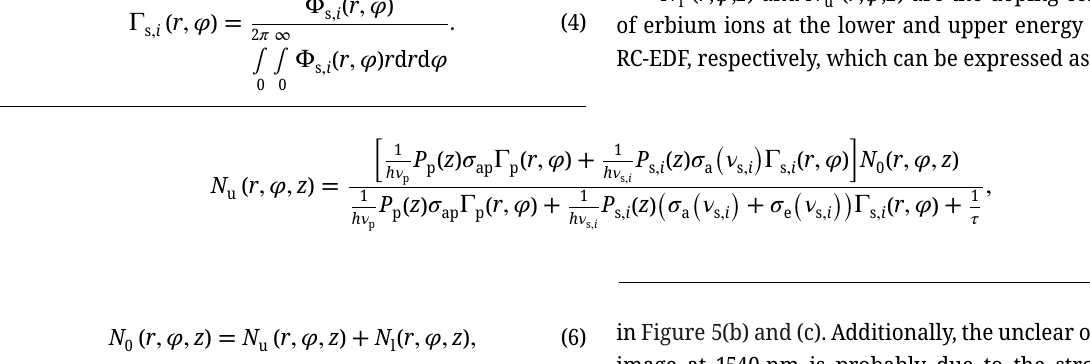
mode at the wavelength of 980 nm, and the erbium 1